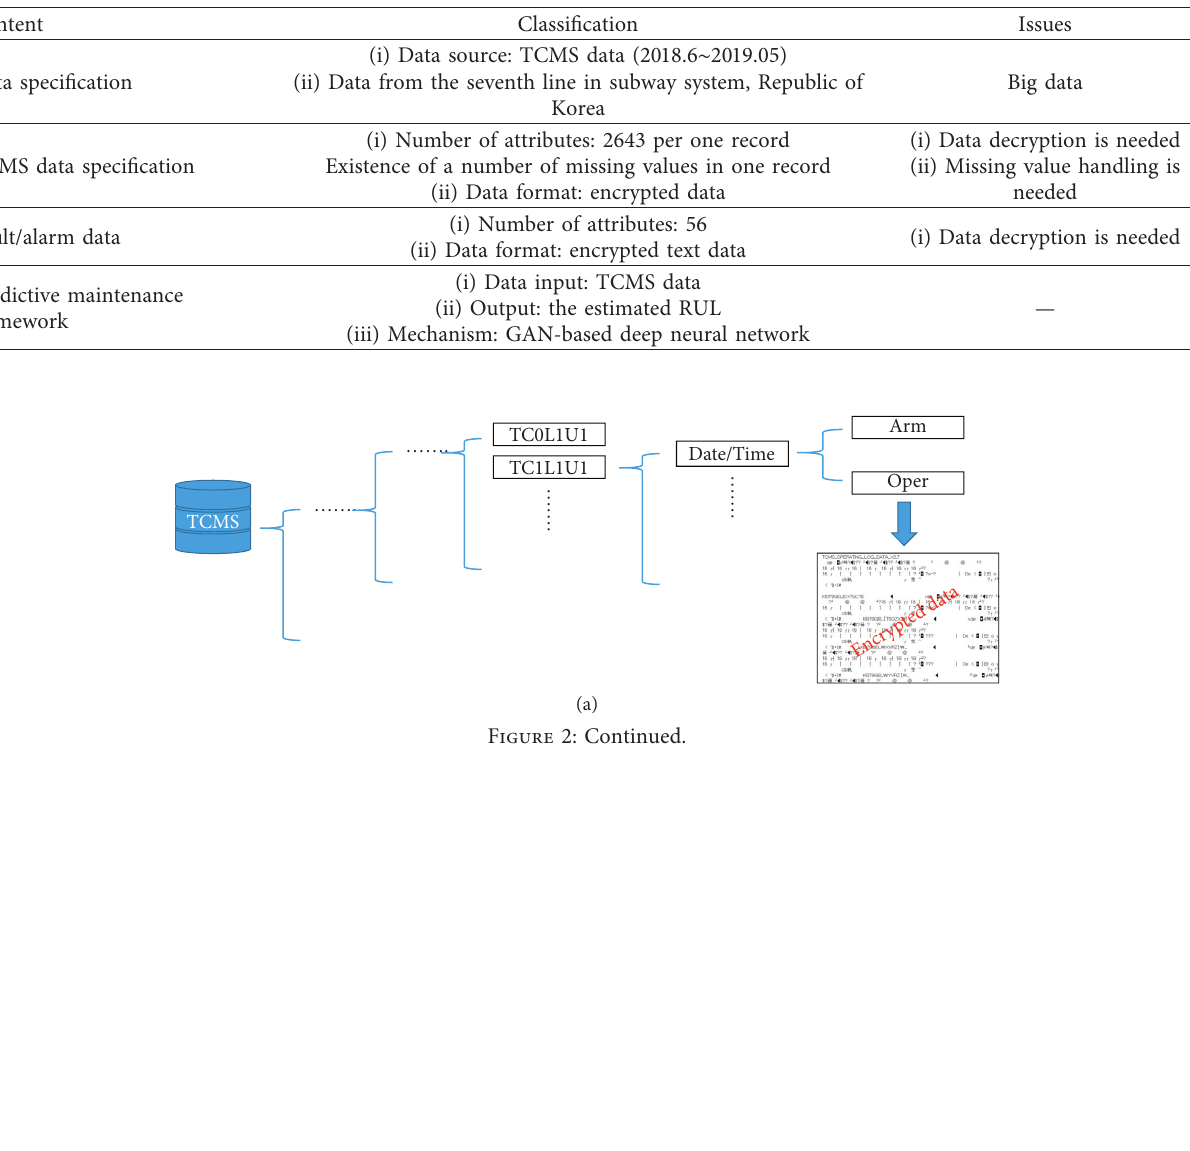
Table 3: Specification of the proposed predictive maintenance